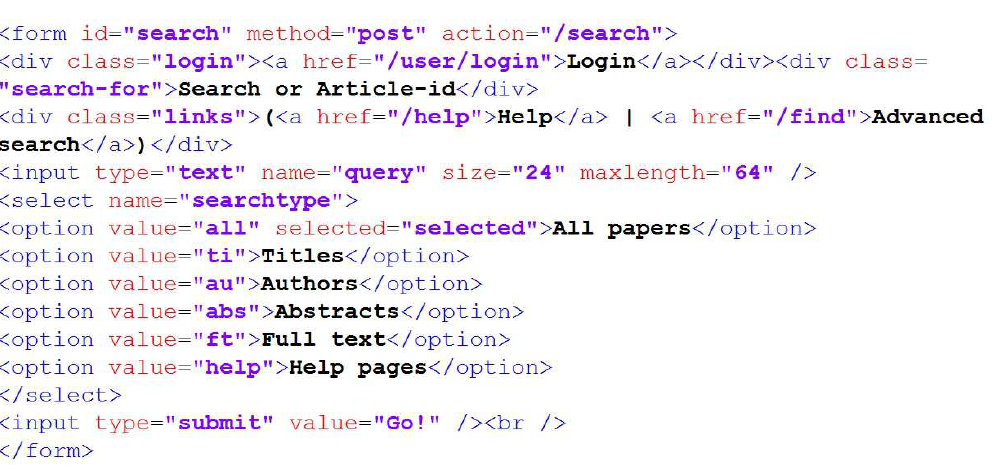
Figure 2. Arxiv search interface: HTML source